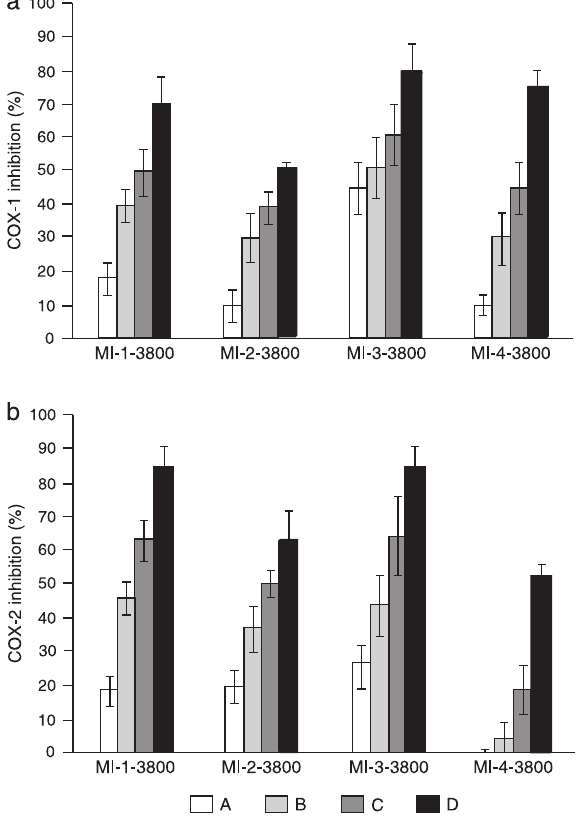
Figure 1. Effect of different phenolic compound concentrations (reported as µg/mL of gallic acid equivalent) of the standardized extracts on PGE 2 release by a , COX-1 and b , COX-2 (reported as inhibition percentage). The concentrations assayed for MI-1- 3800, MI-2-3800, MI-3-3800 were 2, 4, 6, and 8 µg/mL and for MI- 4-3800 were 2, 4, 8, and 16 µg/mL (A, B, C and D, respectively). The results (means ± SD, N = 3) of three separate experiments are shown. PGE 2 = prostaglandin E 2 ; COX = cyclooxygenase.